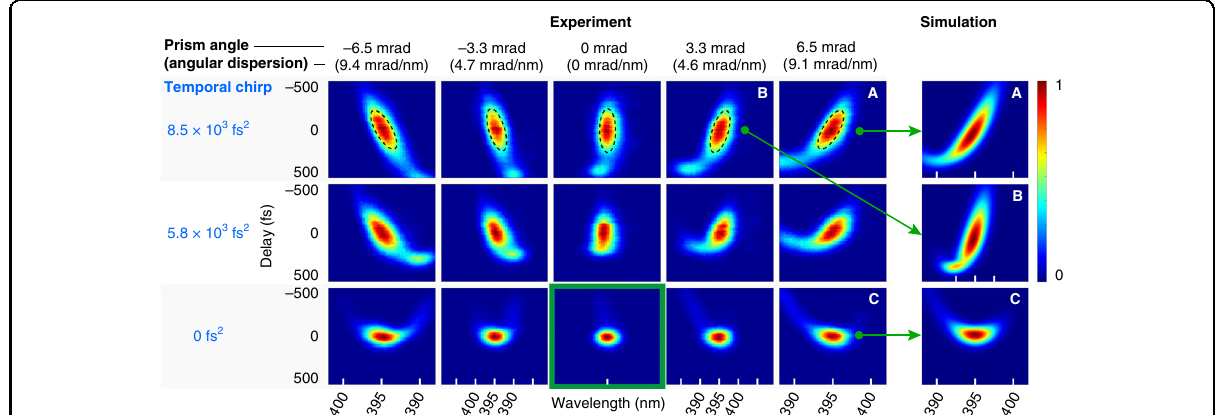
Fig. 5 Cross-correlation of pulses with angular and temporal dispersion. In the table, each trace shows the diffraction ef fi ciency in arbitrary units as a function of delay (vertical axis) and spatial direction k y (horizontal axis, k y = [ − 1.03; 1.03] μ m − 1 ). The left table shows experimental results for 15 different combinations of temporal chirp ϕ 2 and angular dispersion. The angular dispersion has been numerically characterized from the prism angle mismatch. The value of second order phase ϕ 2 has been characterized from the prism insertions in the prism compressor ( fi rst row 3 mm, second row 2 mm, and last row 0 mm. The latter is the position for optimal pulse compression). For each trace, the horizontal axis scale has been converted to wavelength using the angular dispersion coef fi cient. When the angular dispersion is removed (central column), all wavelengths have the same direction k y . In this case, the lateral width of the spot is simply determined by the Gaussian beam size. To show the consistency of the results, the rightmost column show three cases (A, B, C) where analytical formula for the diffraction ef fi ciency of the transient grating has been integrated using the parameters extracted from the ZEMAX simulations of the misaligned prism compressor (see “ Methods ”